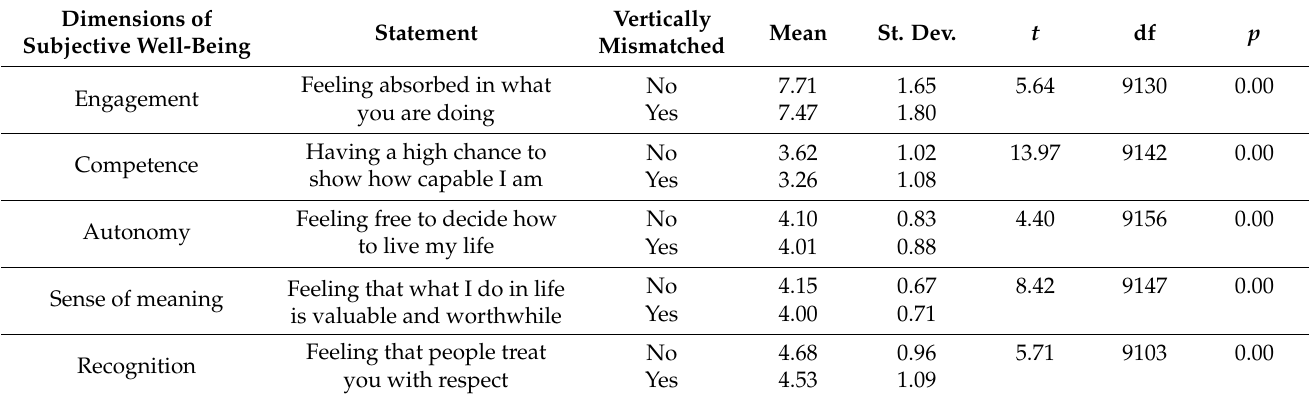
Table 1. Statements regarding the five dimensions of subjective well-being among graduates for which a significant difference was detected between those who are mismatched and not. Dimensions of Subjective Well-Being